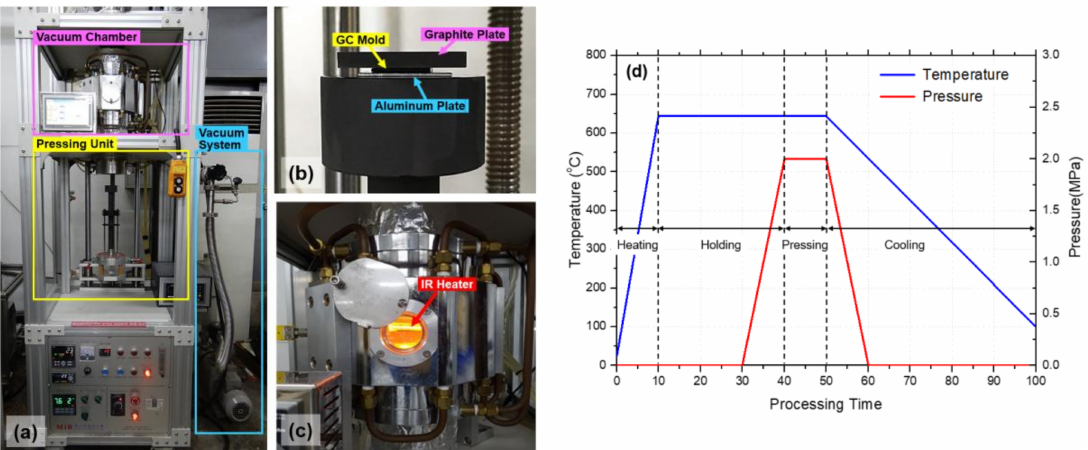
Figure 3. ( a – c ) Photographs of constructed DMF system; ( a ) whole system; ( b ) graphite pressing jig unit with Al substrate, GC mold, and cover graphite plate; and ( c ) vacuum chamber with infrared heater during the heating stage; ( d ) pressure and temperature histories in DMF